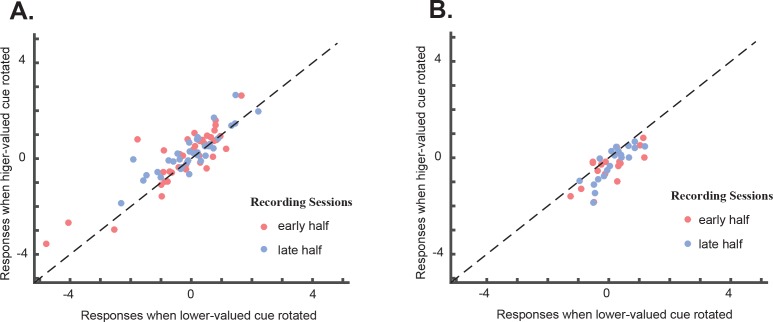
The history of attentional modulation of OFC responses.Here, we replotted Figure 4CD, but now labeling the data points by when the neuron was recorded. We split the whole experiment into two halves. The red dots are the sessions in the early half, and the blue ones are in the late half. They largely overlap, indicating that the response difference between the higher value rotated and lower value cue rotated conditions did not differ between the early and the late recording sessions in the study. (Two-tailed t-test. p=0.9244 for the positively tuned neurons; p=0.7898, for the negatively tuned neurons). (A) positively tuned neurons, (B) negatively tuned neurons.